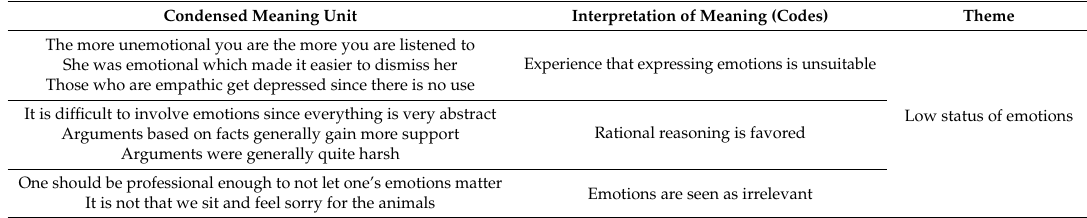
Table 1. Example of how interview themes were derived through thematic